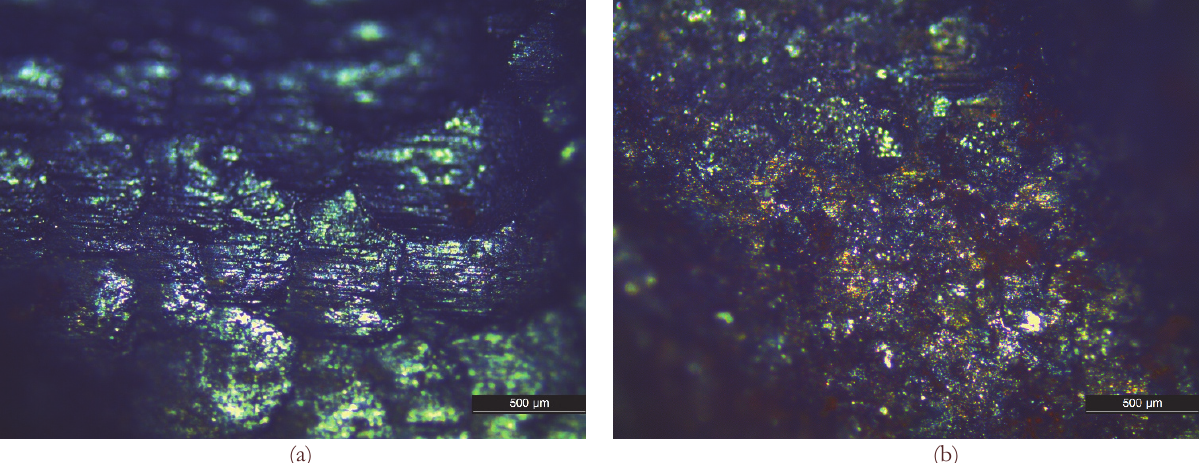
Figure 5: Images of (a) non-blasted and (b) sandblasted surfaces of the steel bars